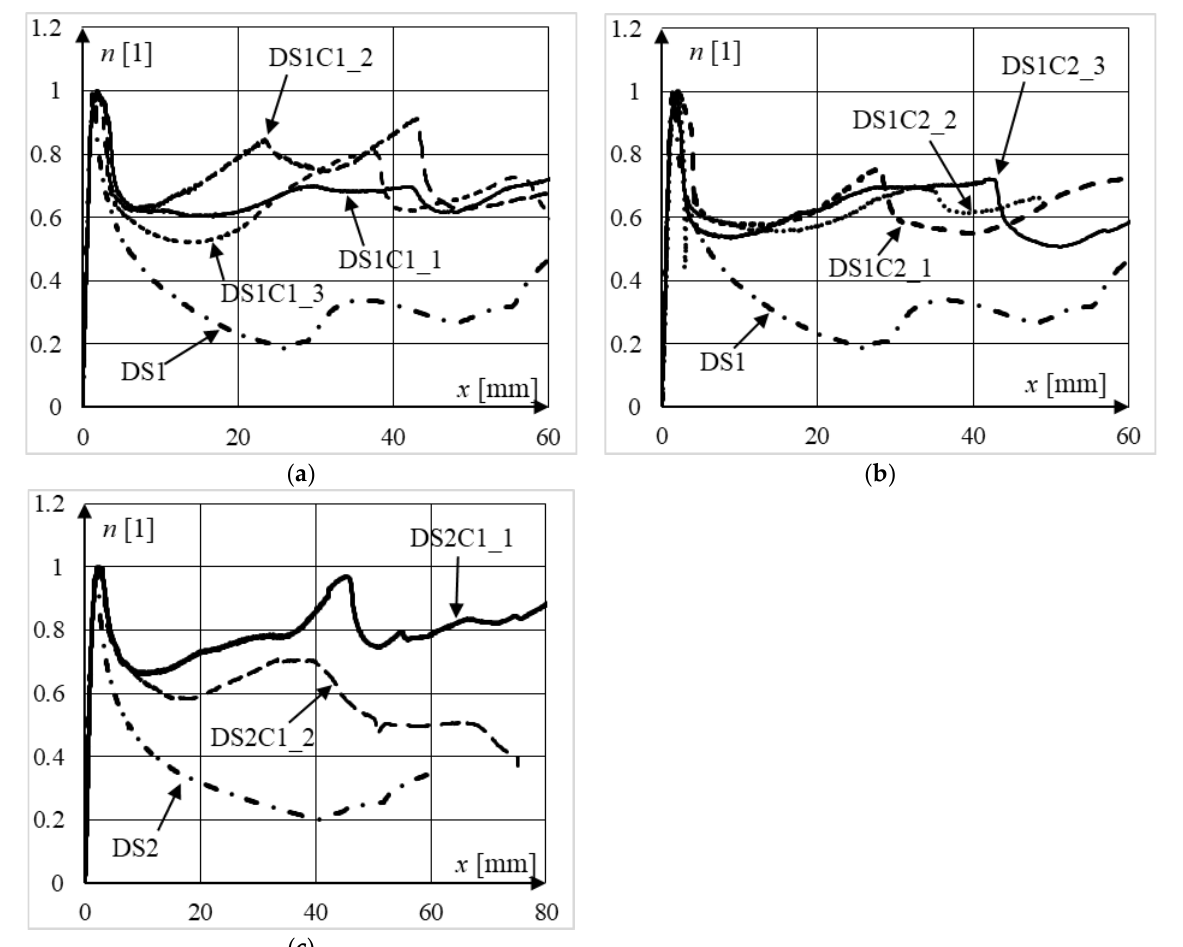
Figure 13. Normalized equilibrium paths of moderately slender elements from series: ( a ) DS1C1, ( b ) DS1C2, ( c ) DS2C1.